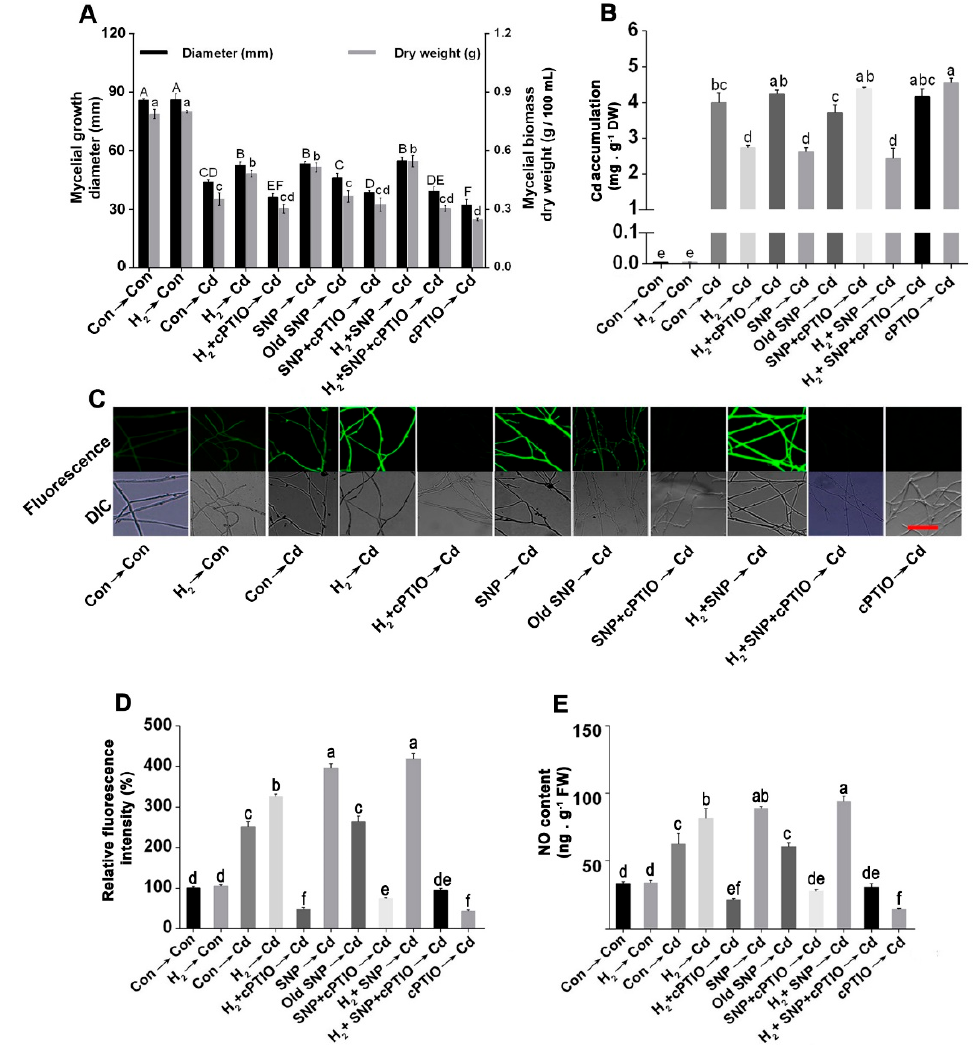
Figure 4. H 2 -enhanced NO production was susceptible to the NO scavenger cPTIO. Two − day − old mycelia were either pre-treated or not with 3% H 2 fumigation for 24 h. In all tests of this experiment, stressed mycelia were either treated or not with 500 μ M SNP, 500 μ M old SNP, or 500 μ M cPTIO alone or in the indicated combinations for 30 min after H 2 pre-treatment. On the 4th day, 6 − mm − di- ameter mycelial discs from the different treatments were cut and grown for 8 d on solid CYM with or without 1.75 mM CdCl 2 for growth diameter observation ( A ; left) or liquid CYM with or without 200 μ M CdCl 2 for biomass dry weight detection ( A ; right). Simultaneously, on the 4th day, mycelial discs from the different treatments were grown for 12 h or 5 days on stressed solid CYM. Five − day − stressed or non-stressed mycelia were sampled for Cd accumulation measurement ( B